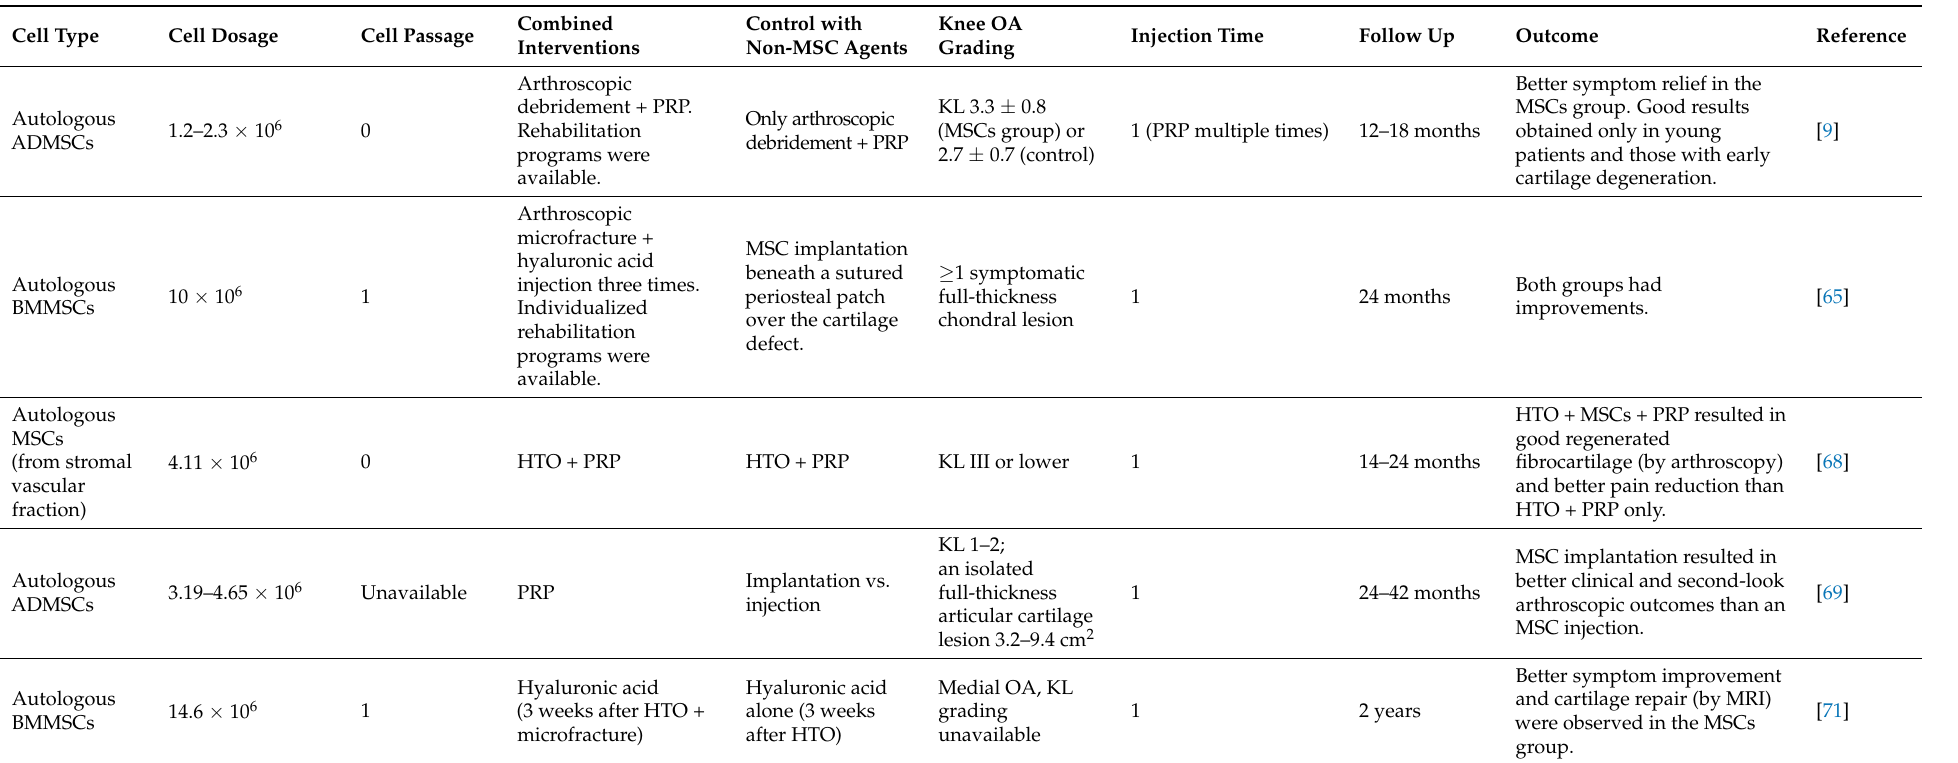
Table 4. Injections vs. surgery and